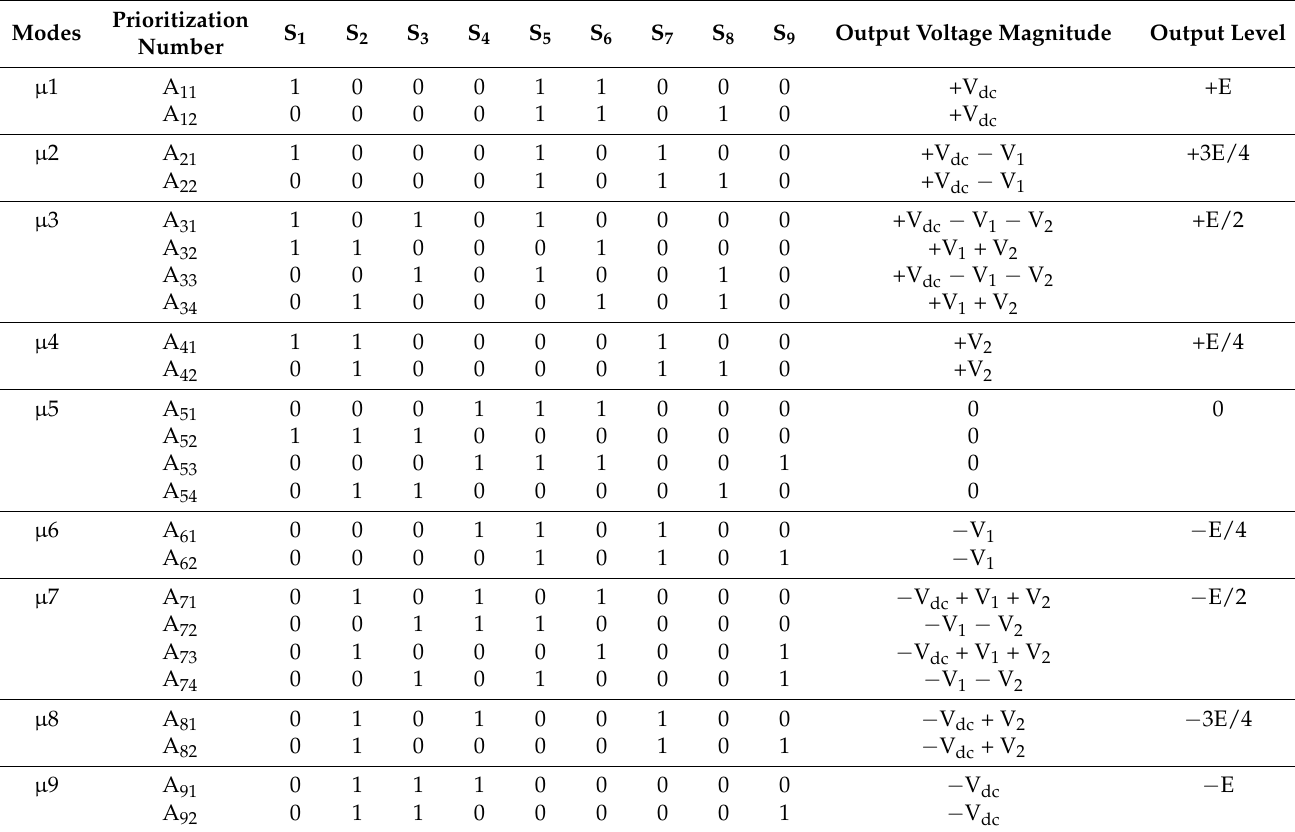
Table 3. Operating modes of FT-MLI topology for PEC9 FT